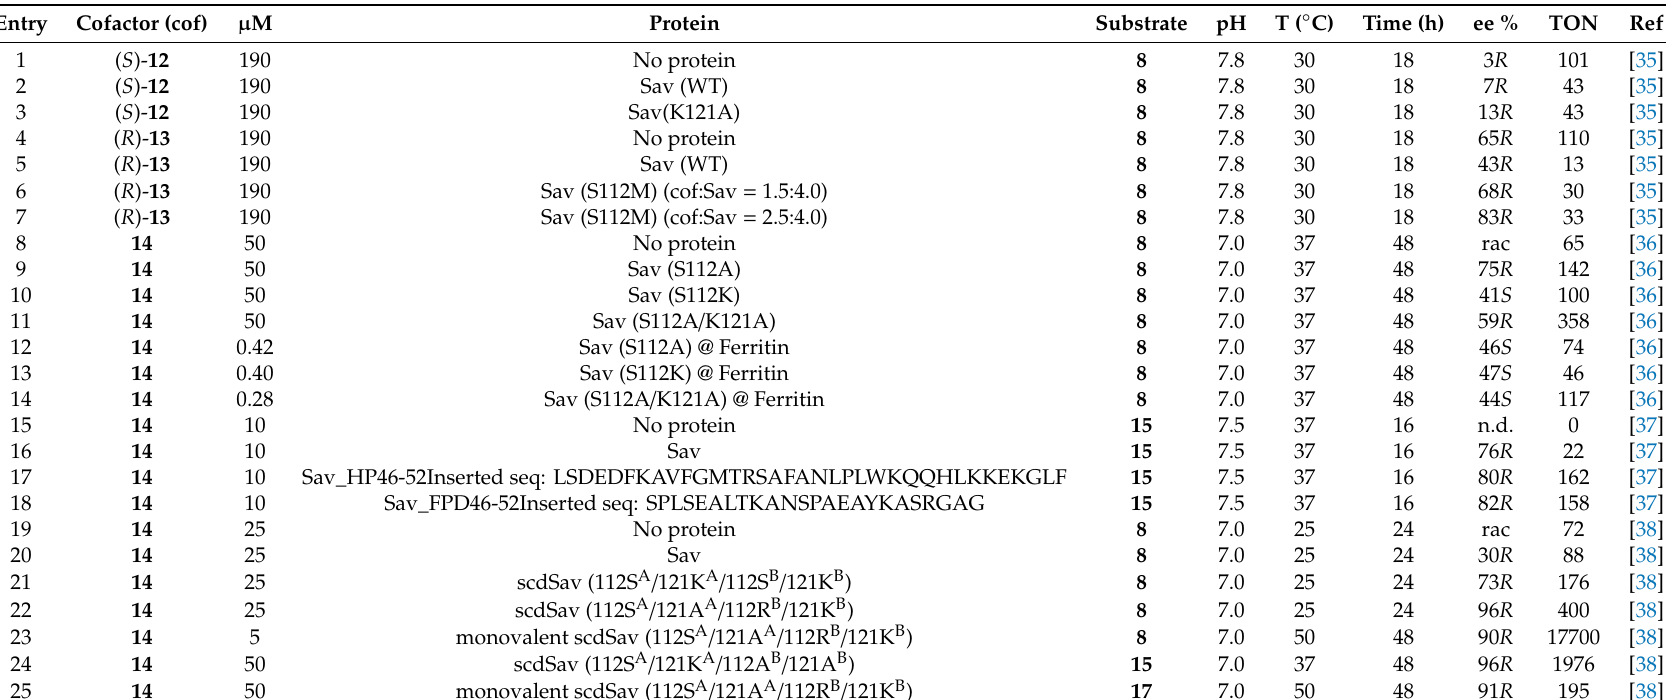
Table 1. Selected results of transfer hydrogenation of imines catalyzed by Sav-based artificial transfer hydrogenases